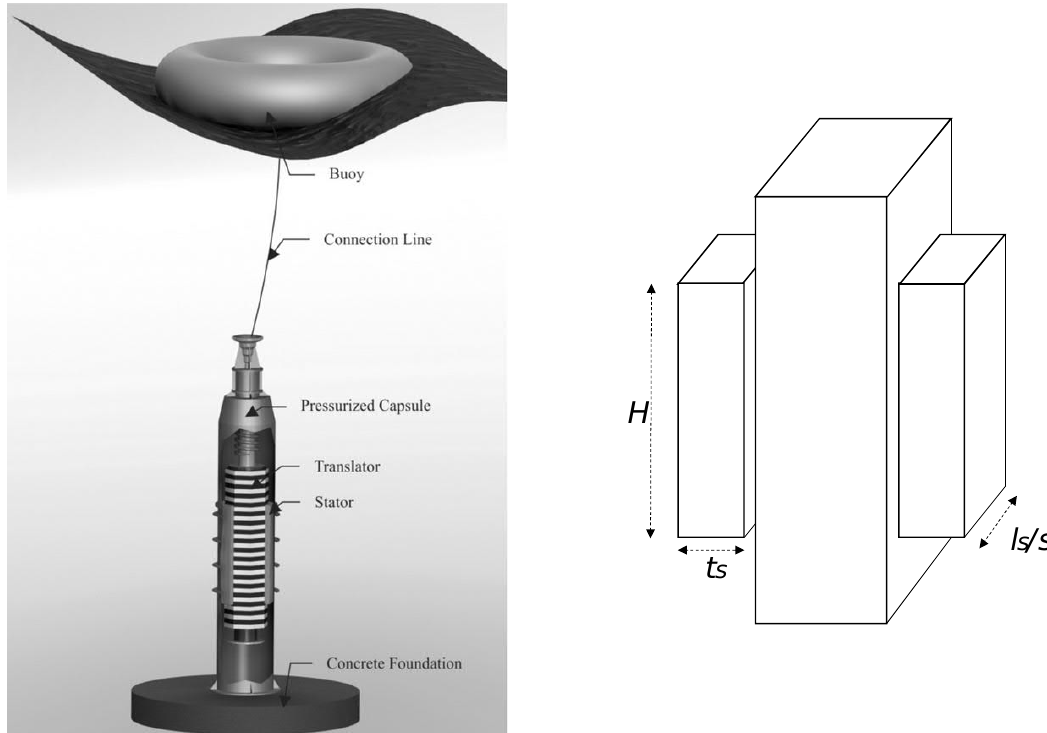
Figure 1. Left : Sketch of the wave energy converter concept from [18] licenced under CC BY 3.0 https: //creativecommons.org/licenses/by/3.0. Right : Sketch of linear generator geometry. The figure shows two out of four sides of the generator stator and the geometrical parameters of the stator. The translator is in the middle and moves up and down. H denotes stator height, l s the total stator length, t s the stator thickness and s the number of stator